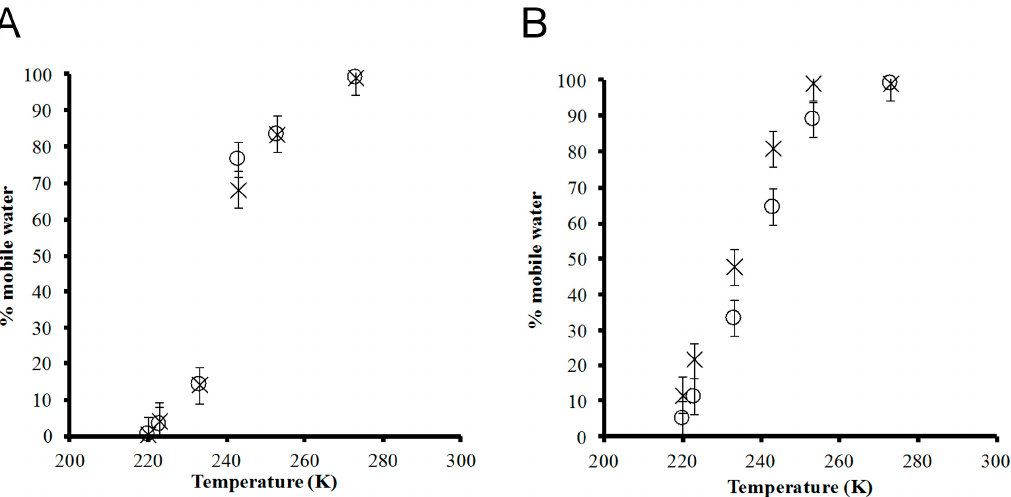
Figure 3. Non-spinning 2 H NMR spectra were used to quantify (peak areas) the relative mobile water content as a function of temperature in the hydrogels ( A ) × 1K0 and ○ 1K25 and ( B ) × 5K0 and 5K25. The mobile water content is expressed as a percentage of the initial water content at room temperature.